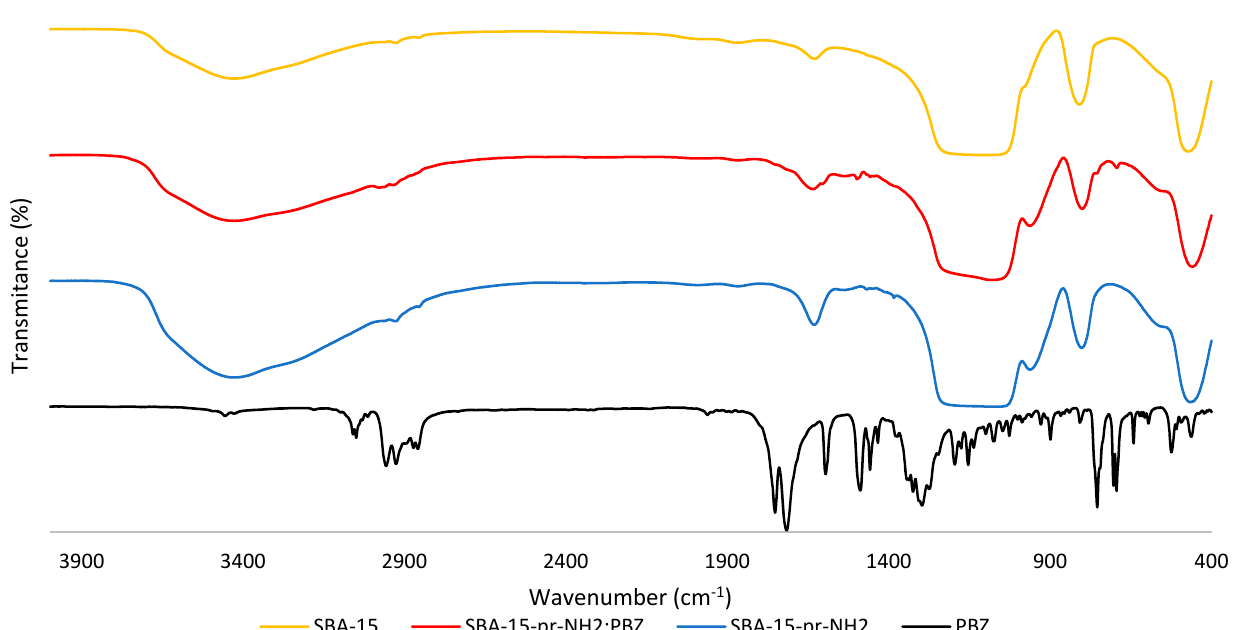
Figure 6. FT-IR spectra of SBA-15, SBA-15-pr-NH 2 , SBA-15-pr-NH 2 :PBZ, and PBZ.